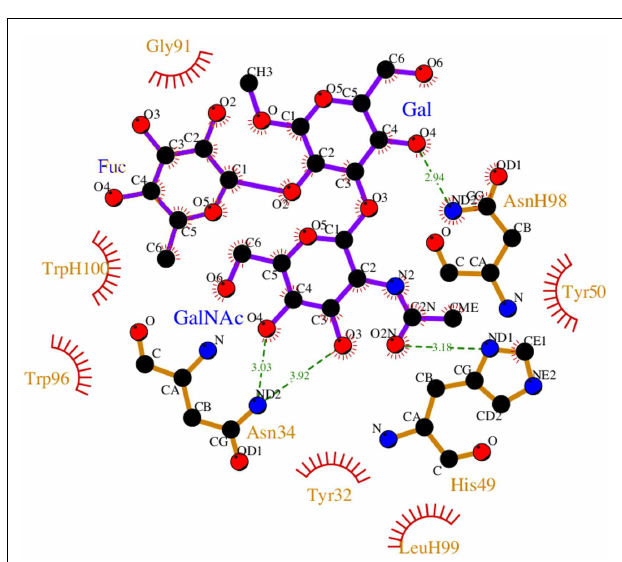
FIGURE 3 | Non-bonded interactions between the BGA and FabAC1001 [prepared using LigPlot (38)] .The structure represents a single frame of the MD simulation that is closest to the average RMSD of the structure during the simulation. Unless shown with an H, all residues are fromVL.